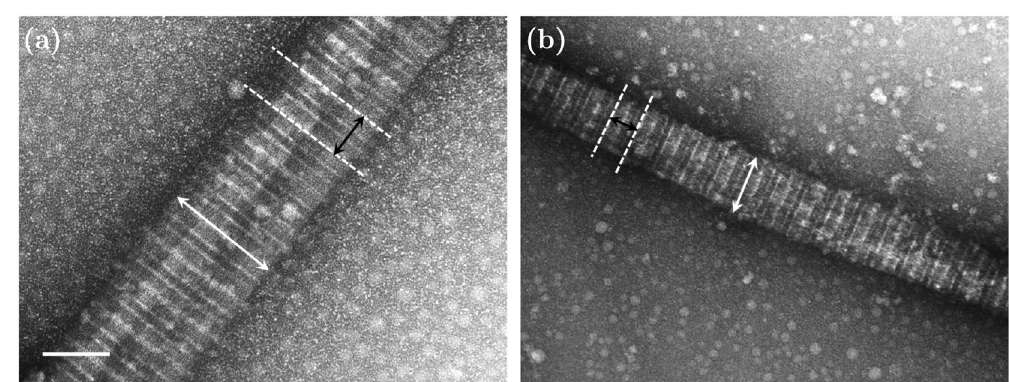
Figure 3. Representative transmission electron microscopic (TEM) images of collagen fibrils (magnification: 50000). ( a ) 100% collagen type I in the solution; ( b ) Col-III:Col-I of 50:50; The average topology of the fibrils such as their diameter and D-banding slightly changes when adding tropocollagen type III to the solution. The scale bar represents 100